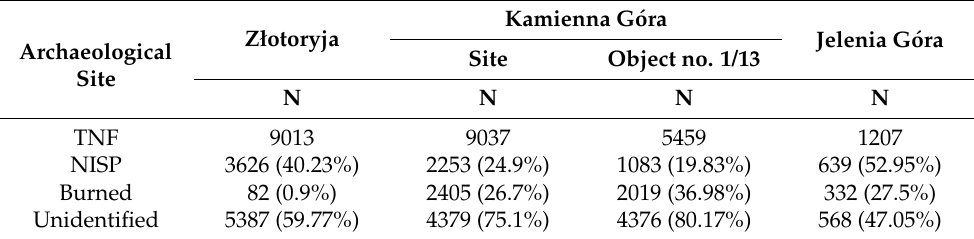
Table 1. Percentage of bone remains with absolute values at investigated gallows. N—number of specimens, TNF—total number of fragments, number of identified specimens (NISP), burned— burned specimens (unidentified and identified), unidentified—number of unidentified